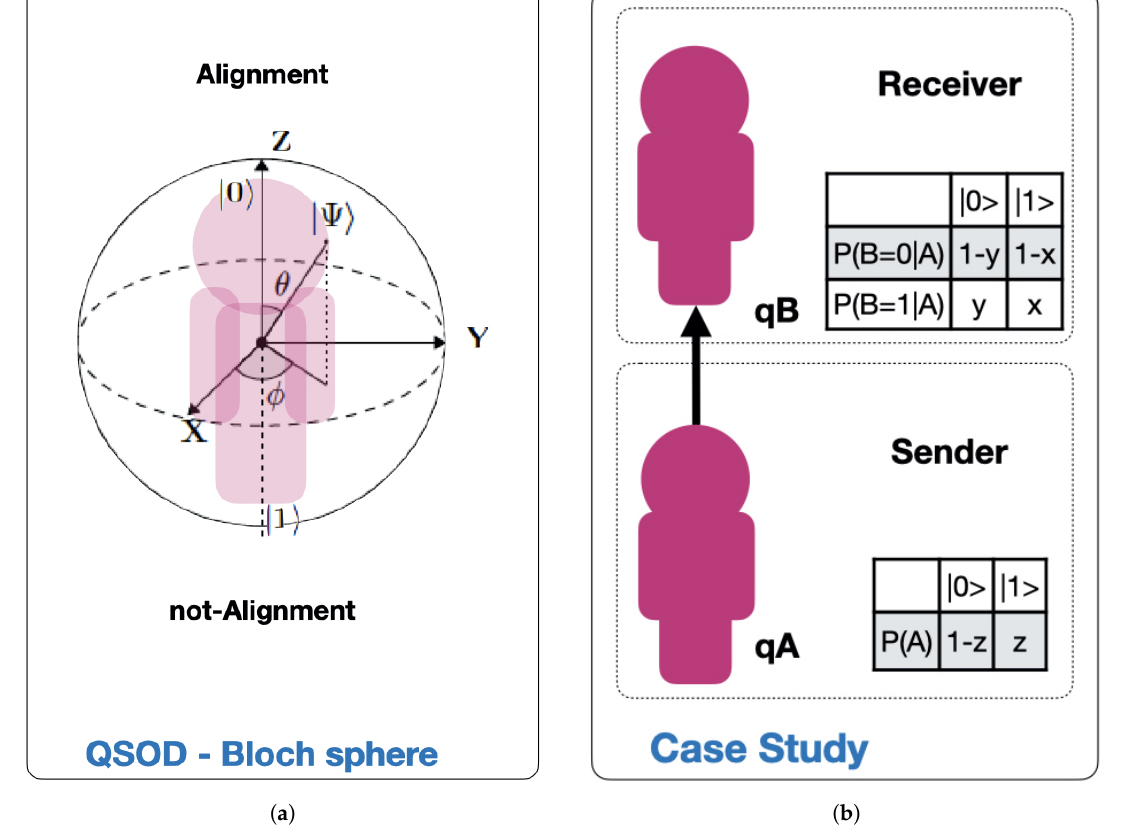
Figure 1. ( a ) Case study framework, ( b ) quantum simulation of strategic organizational design (QSOD)—Bloch